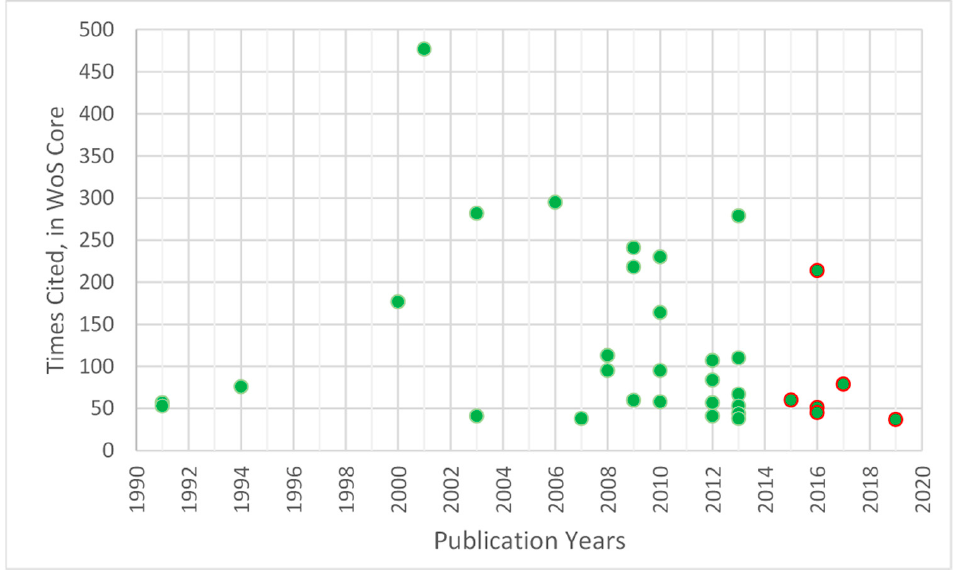
Figure 5. Box plot of citations received per article on coffee/caffeine and sport.